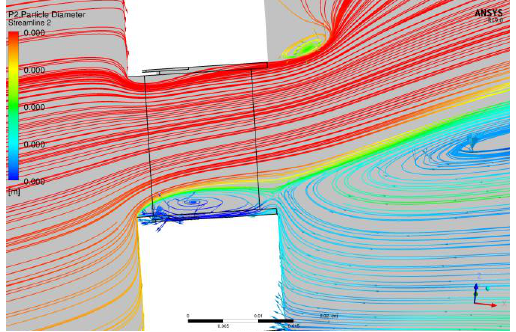
Fig. 8. Surface streamline colored by particle diameter of fluid phase P2